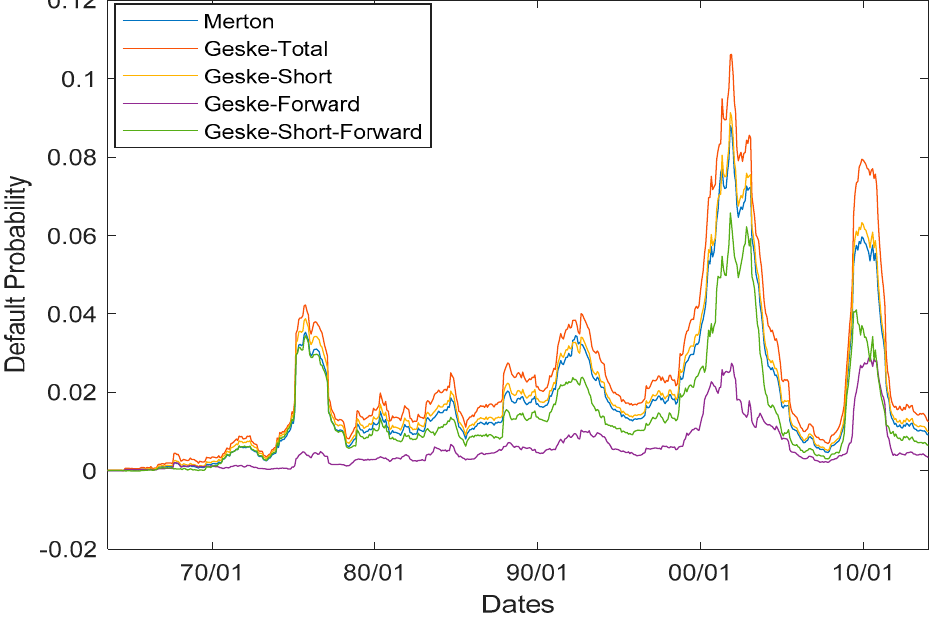
Figure 1. Default probabilities.